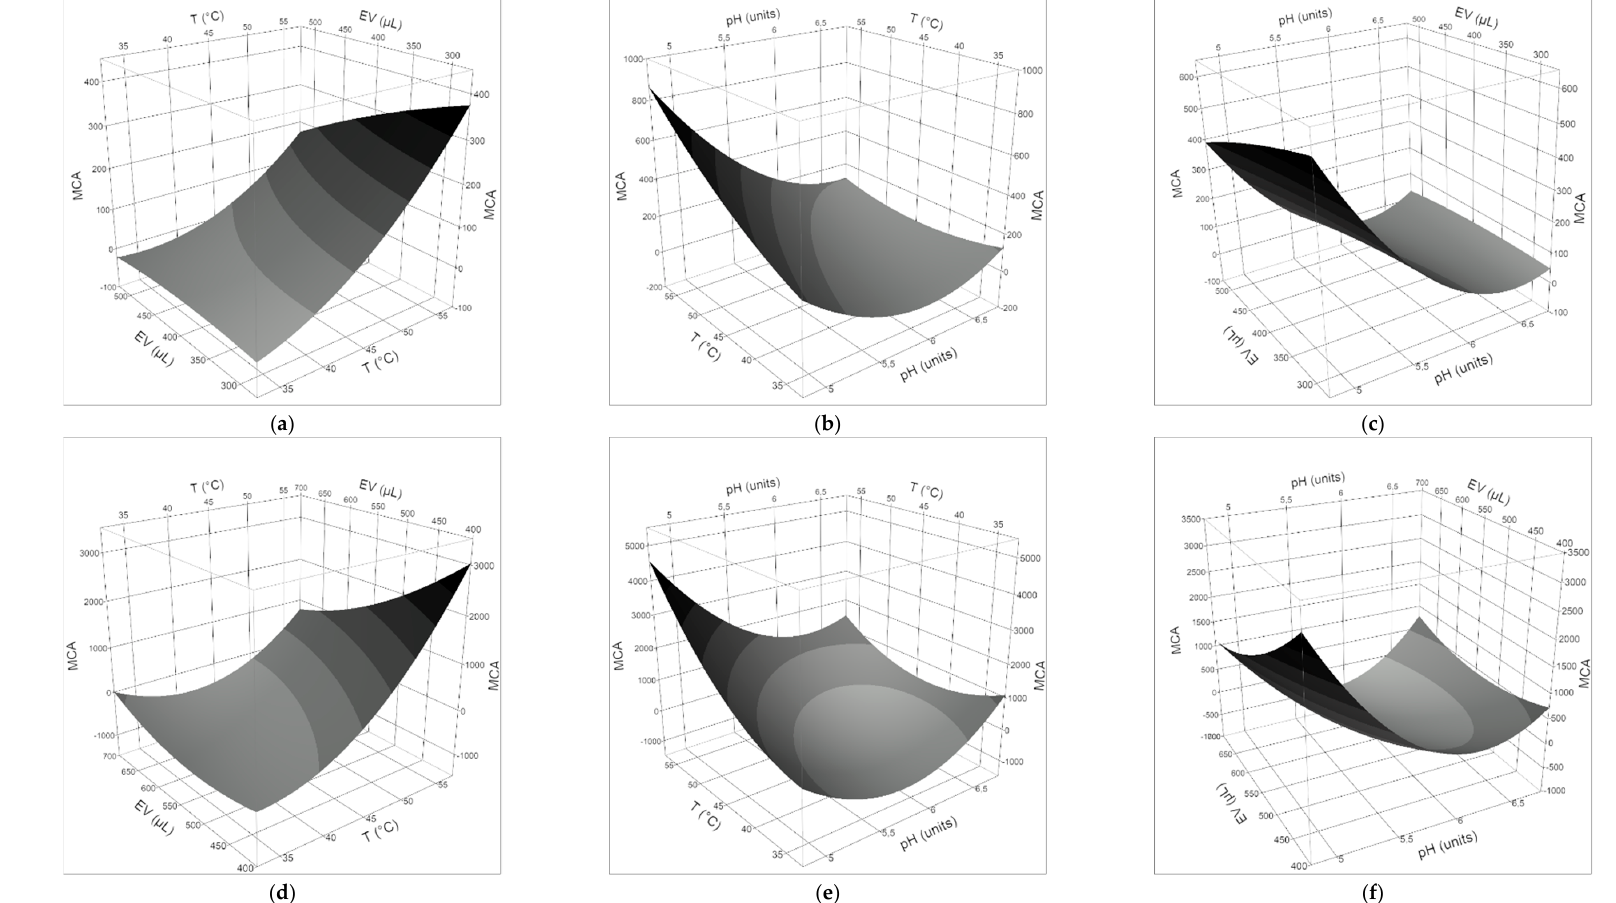
Figure 3. Response surface plots for the effects of ( a ) coagulant volume and temperature; ( b ) pH and T; ( c ) pH and coagulant volume, on the clotting activity of O. tauricum extract in goat’s milk; ( d ) coagulant volume and temperature; ( e ) pH and T; ( f ) pH and coagulant volume, on the clotting activity of commercial rennin in goat’s milk.